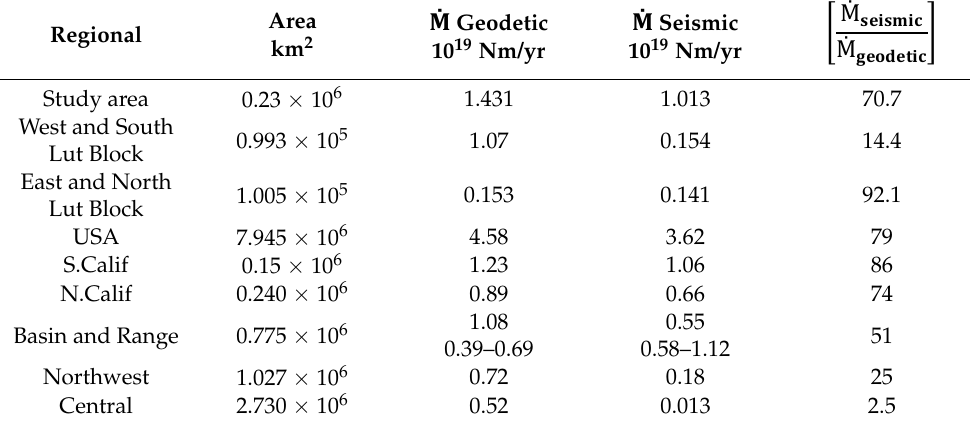
Table 11. The ratio of the seismic/geodetic moment rates in the different areas [1–3]. Regional